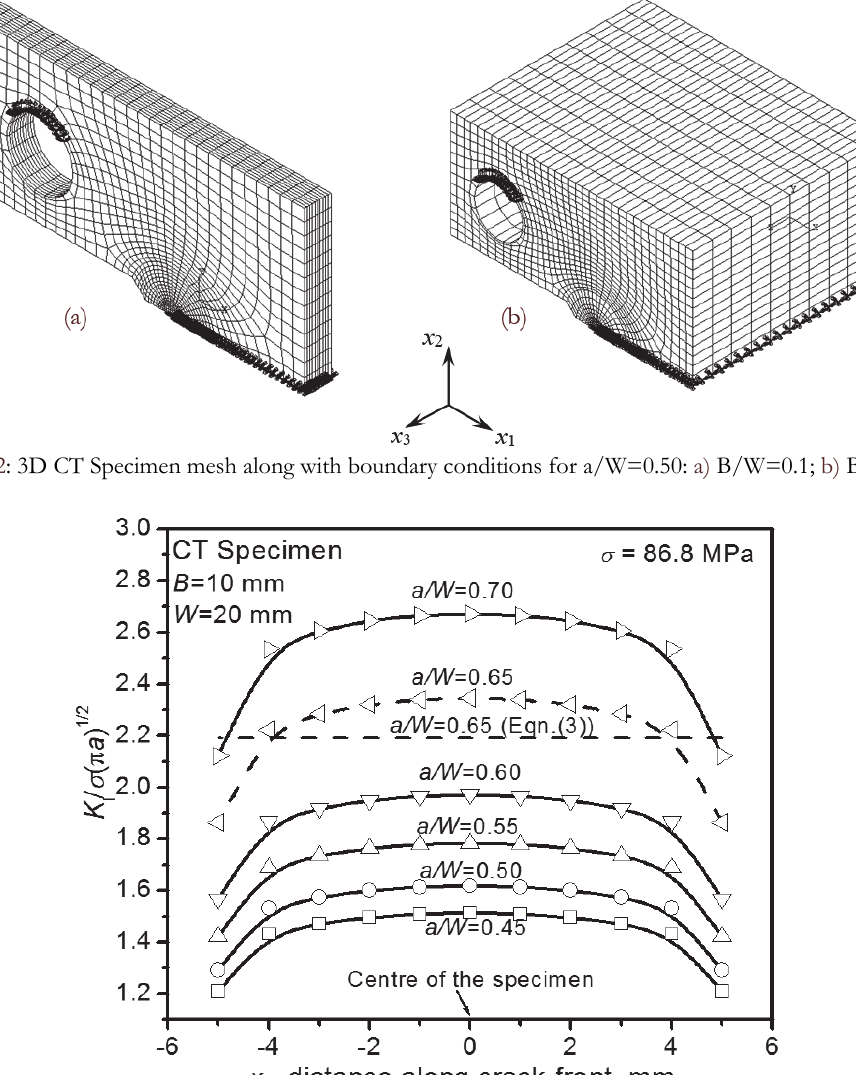
R ESULTS AND DISCUSSION Stress Intensity Factor (K